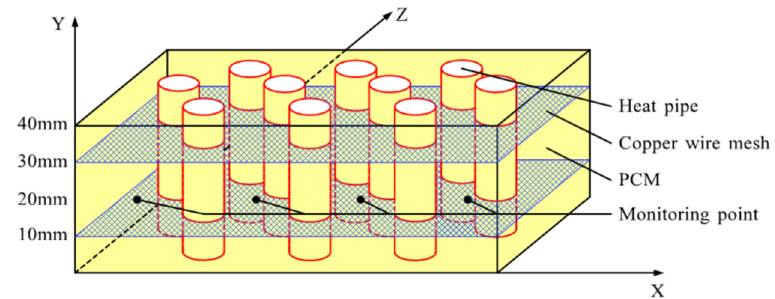
Figure 5. Locations of monitoring points in the PCM container.